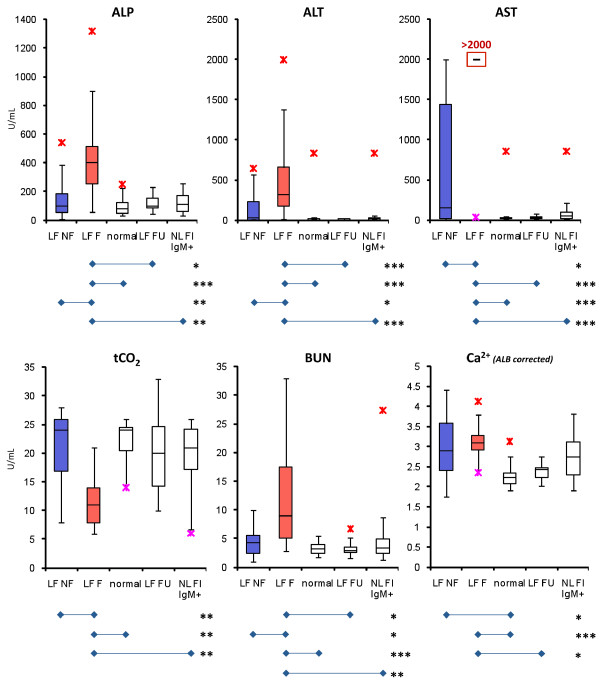
Relevant metabolic indicators in LF pathogenesis. Hepatic enzymes ALP, ALT, and AST were highly elevated in LF patients, particularly for LF F patients. AST levels were the best prognosticator in LF, with nearly all fatal cases showing extremely high levels. Dissolved tCO2 levels were significantly lower than normal for LF F patients, whereas BUN levels were significantly higher than normal. Serum calcium levels (corrected for serum albumin levels) were elevated in LF patients regardless of eventual outcome, but no differences in elevation were observed between acute LF groups. Lower and upper outliers are denoted with pink and red asterisks (*), respectively. Significant p values are denoted as * p < 0.05; ** p < 0.01; *** p < 0.001.